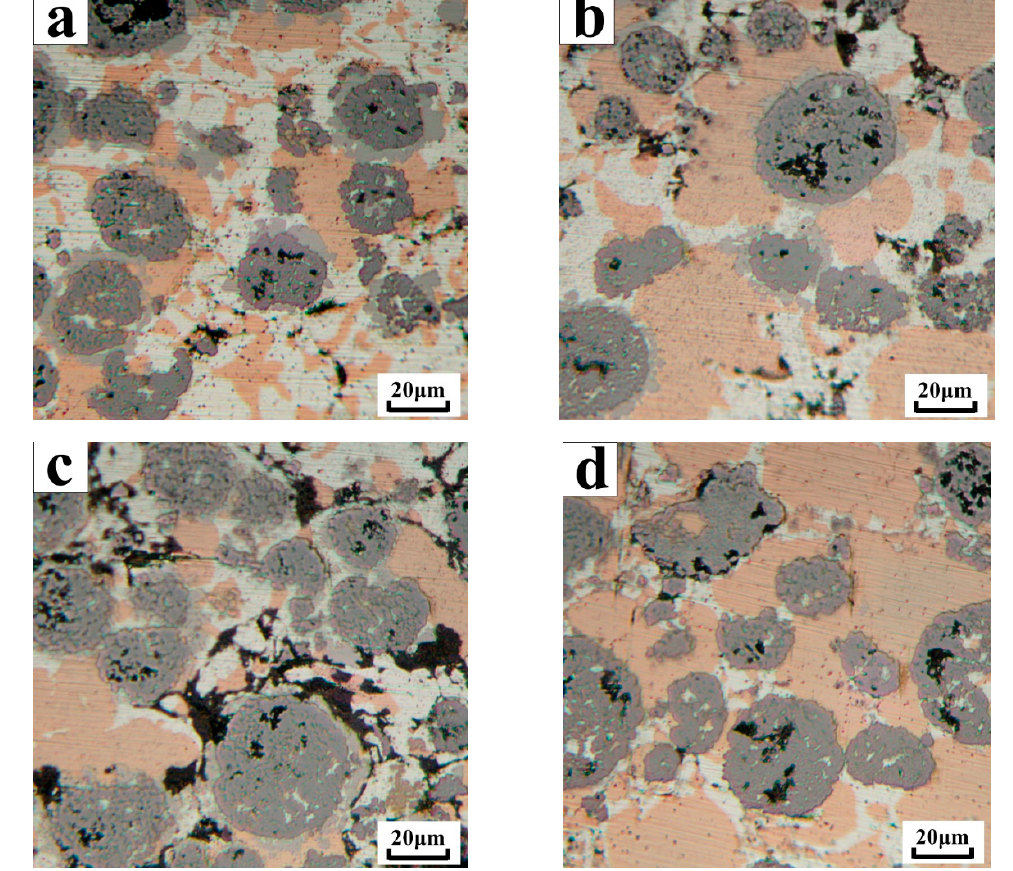
Figure 5. Transition layer changes of WC reinforcing particles and AgCuTi solder at di ff erent temperatures ( a ) Transition layer at a brazing temperature of 830 ◦ C; ( b ) Transition layer at a brazing temperature of 860 ◦ C; ( c ) Transition layer at a brazing temperature of 890 ◦ C; ( d ) Transition layer at a brazing temperature of 920 °C.